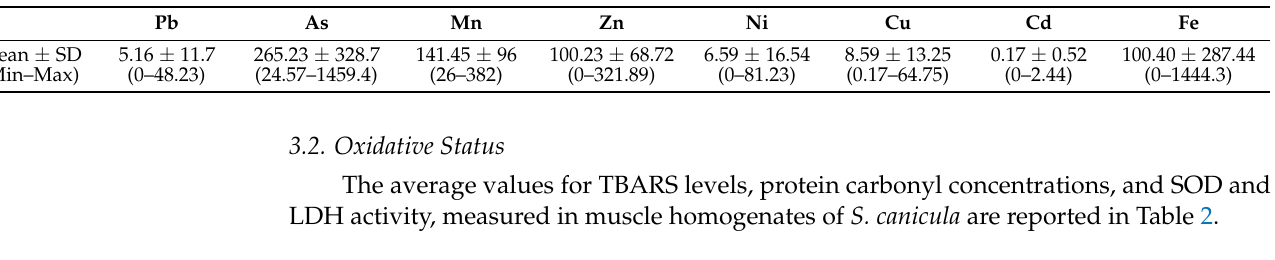
Table 2. Oxidative stress indicators in the muscle tissue of the lesser spotted dogfish S. canicula . Data are shown as the average value, the standard deviation (sd), and the range (minimum–maximum).